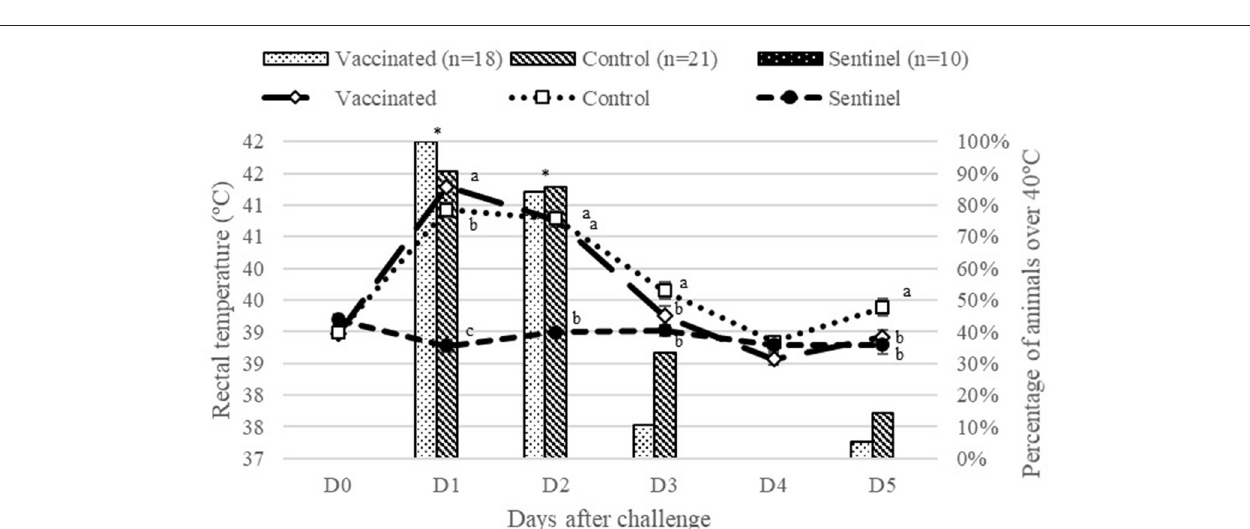
FIGURE 3 | Geometric means of daily shedding (Log 10 of number of genome copies of C. abortus per vaginal swab ± SEM) of control, vaccinated and sentinel group from abortion/parturition to 21 days after experimental infection. *Indicates significant differences ( P < 0.05) between the control and other groups (vaccinated and sentinel).